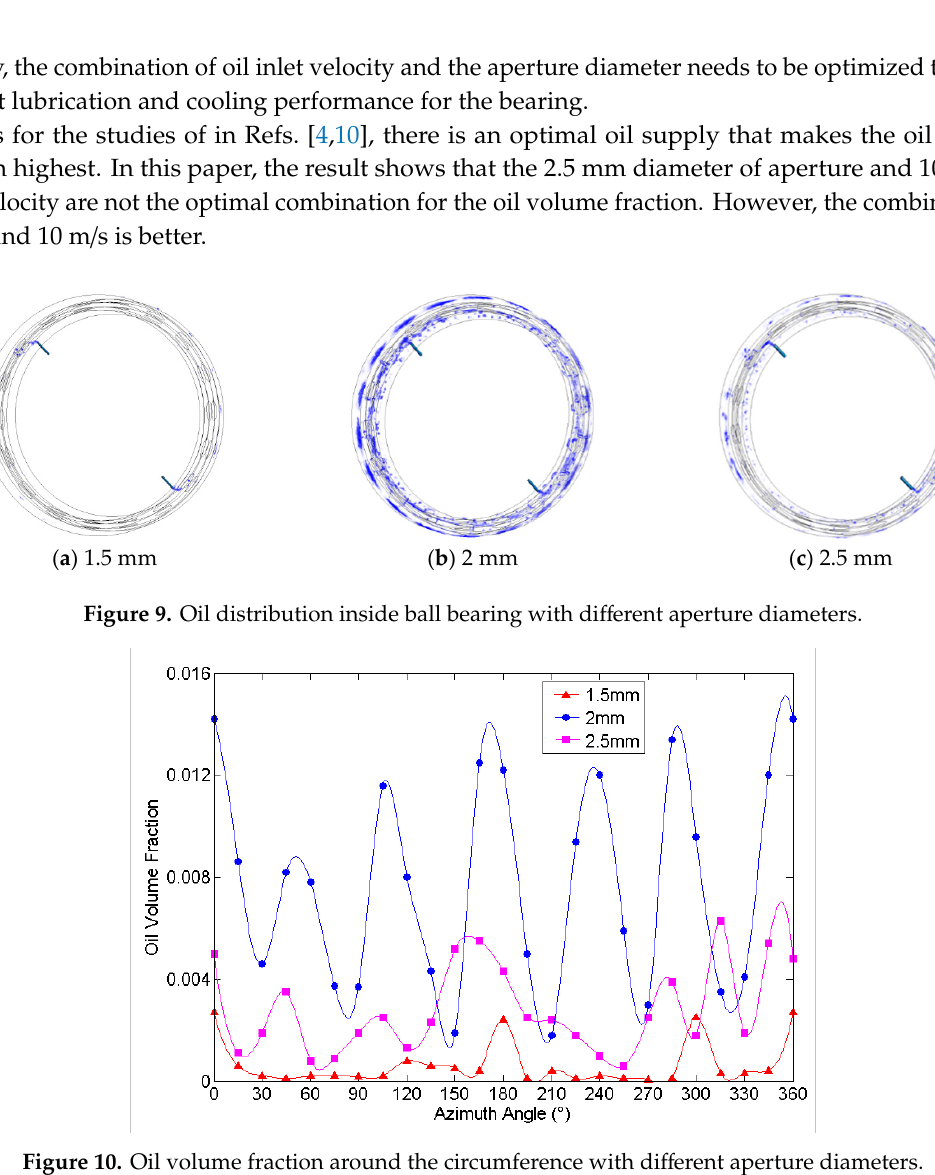
Figure 11. Schematic diagram of geometric parameters of the ball.